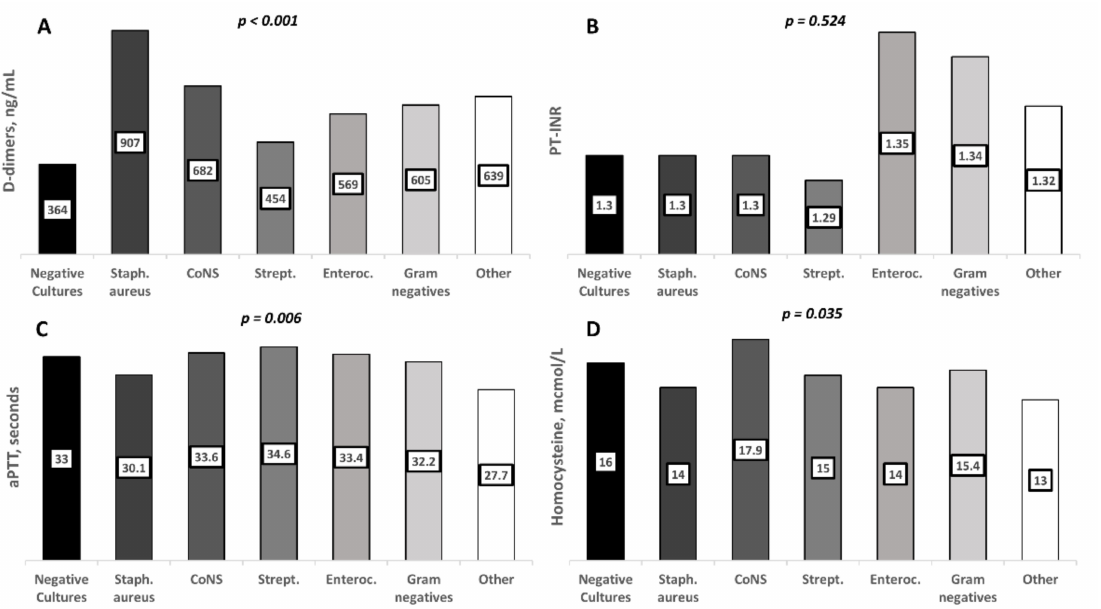
Figure 2. Hemostasis parameters according to the major subgroups of IE causative pathogens. Columns indicate median values for each subgroup: ( A ) D-dimers; ( B ) PT-INR; ( C ) aPTT; ( D ) homocysteine. Abbreviations: CoNS: coagulase-negative staphylococci; Strept: streptococci; Enteroc: Enterococci ; PT-INR: prothrombin time international normalized ratio; aPTT: activated partial thromboplastin time.